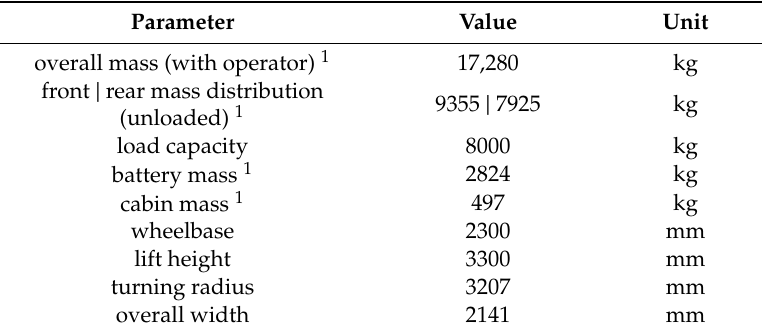
Table 1. Main specifications of the tested